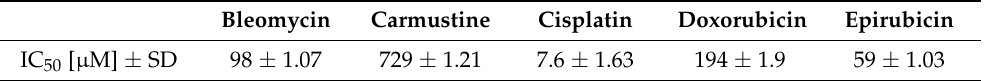
Table 1. IC 50 values of selected chemotherapeutic drugs on Colo 320 cells determined by MTT cell viability assay. For the individual concentrations applied, please refer to Supplementary Material Table S1 (cell density was 10 4 cells/well, treatment time 24 h). Data is represented by mean ± SD.